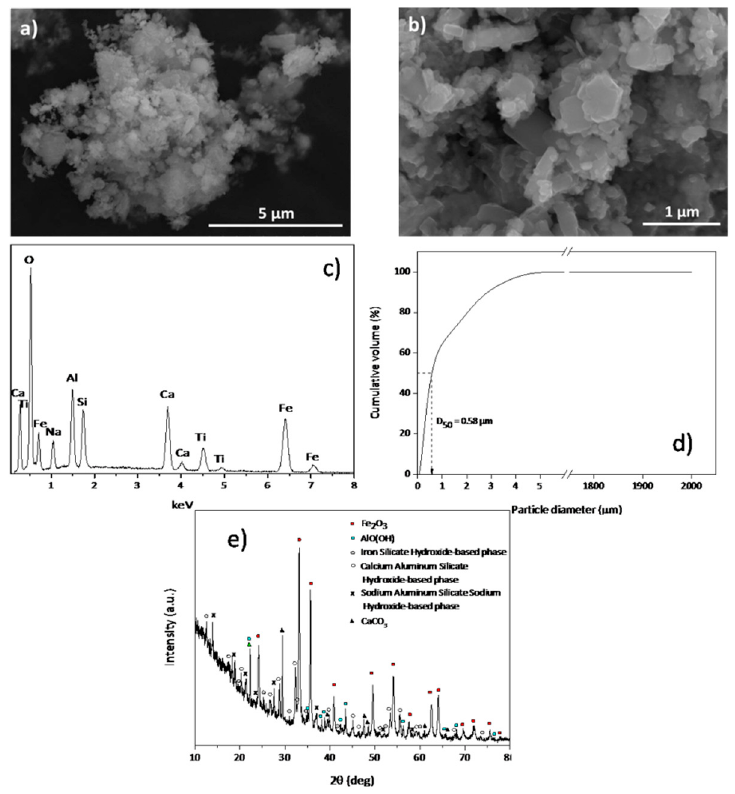
Figure 1. ( a , b ) Scanning electron microscopy (SEM) of the red mud powder; ( c ) EDS spectrograph; ( d ) Cumulative volume (%) of red mud particles; ( e ) XRD pattern of red mud. ( d ) Cumulative volume (%) of red mud particles; ( e ) XRD pattern of red